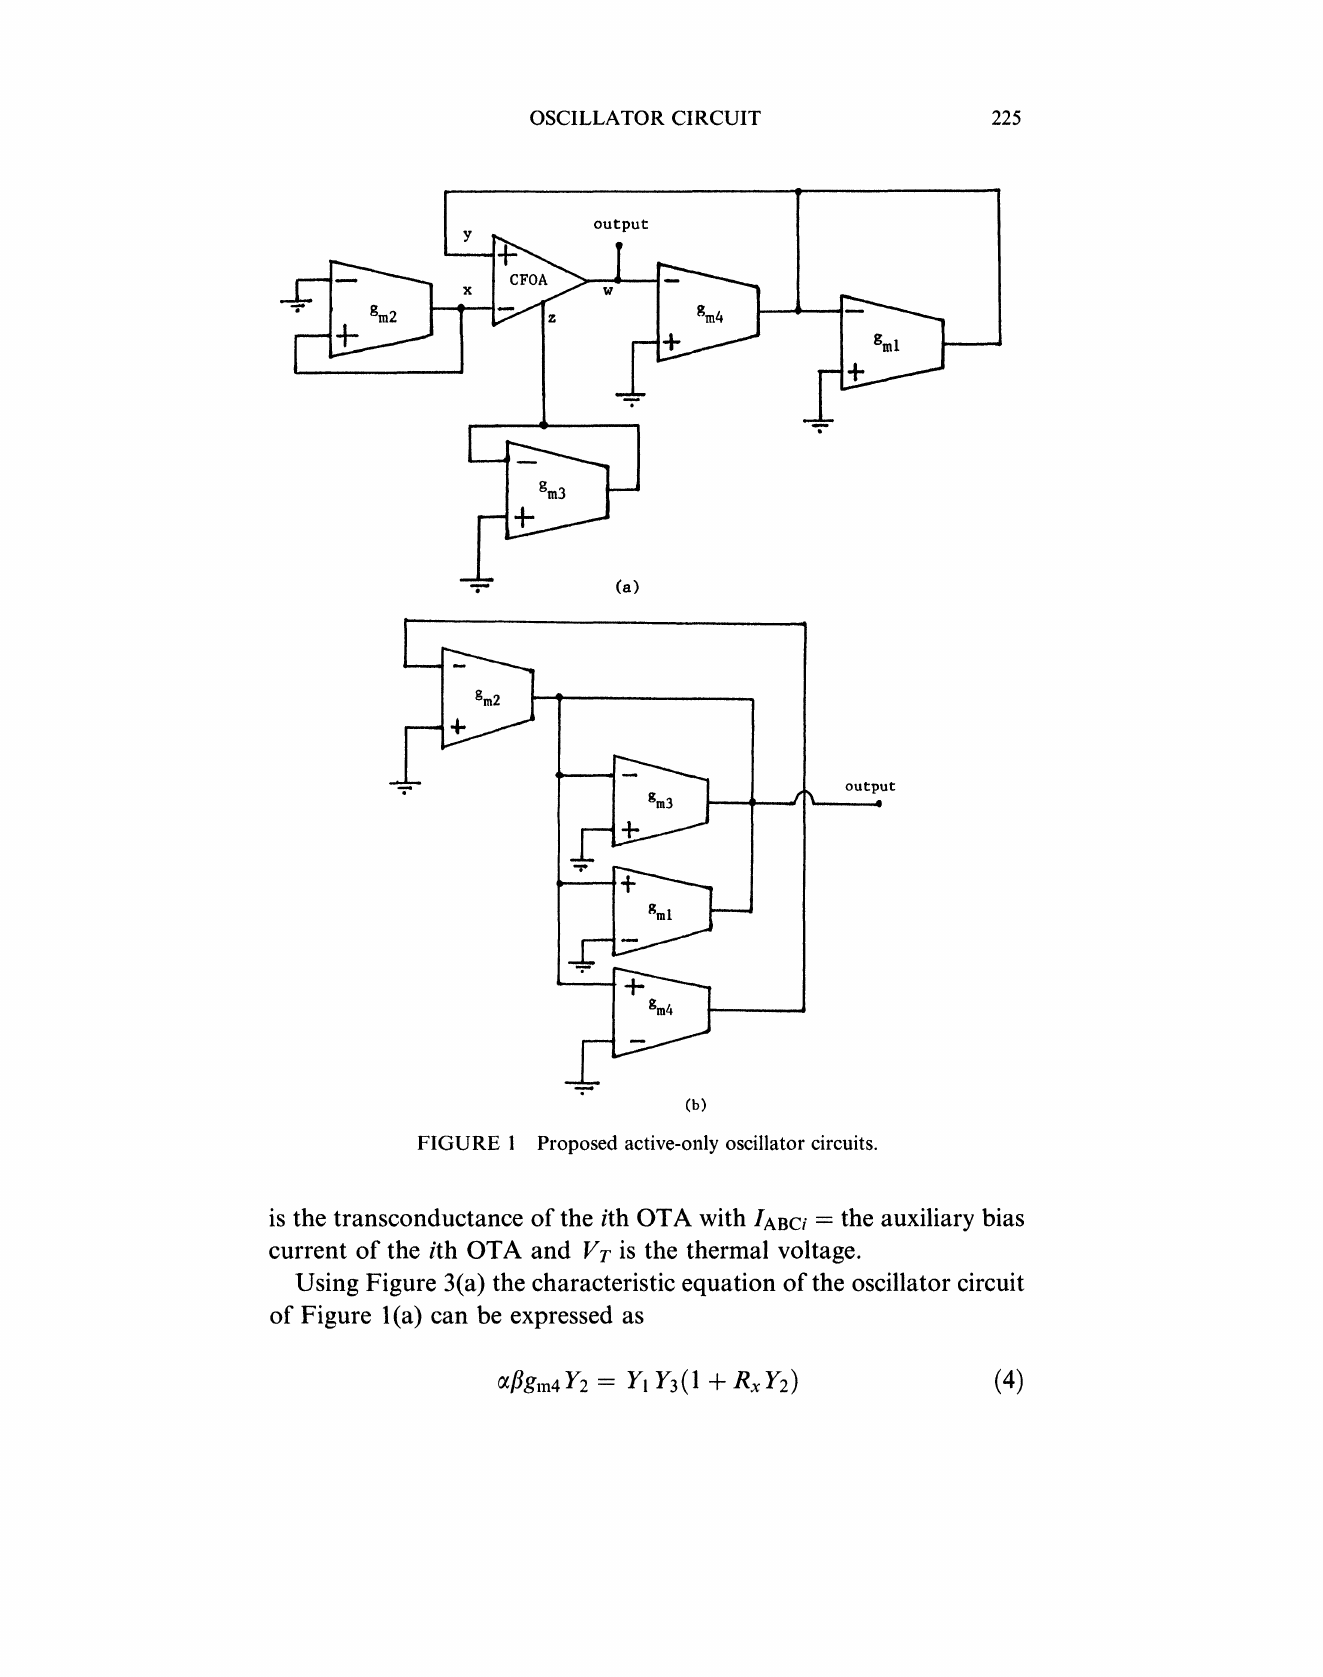
FIGURE Proposed active-only oscillator